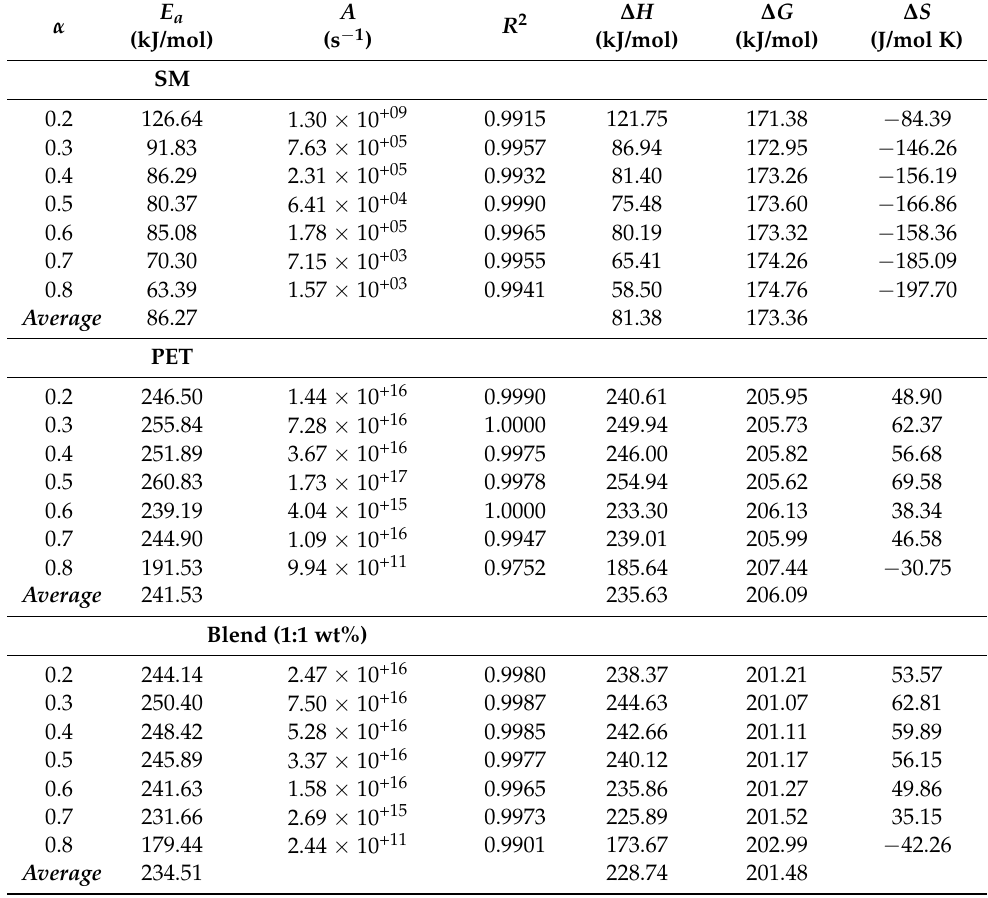
Table 3. Kinetic parameters for the pyrolysis of cattle manure, recycled polyester and their